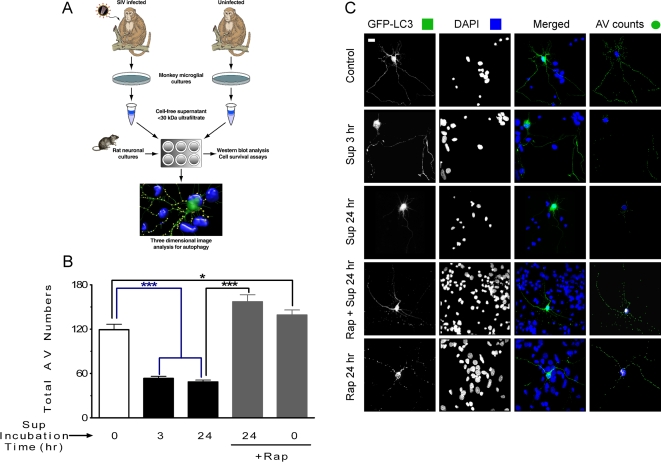

In vitro analysis of the impact of SIV-infected microglia supernatant on autophagy in primary neurons.(A) Model of experimental design, as detailed in the Materials and Methods. (B) Total AV counting results show that a significant drop in the number of AV occurs in neurons exposed to SIV-infected microglia supernatant for 3 or 24 hr. Total number of AV are significantly increased after the pretreatment with rapamycin followed by SIV-infected microglia supernatant (Sup) exposure for 24 hr. *** P<0.001, * P<0.05 for n = 6 experiments. All values are mean±SEM. AV counting using 3D model reconstruction for neurons exposed to different treatments. (C) Flattened images of multi-stack confocal optical slices of neurons transfected with GFP-LC3 (green) to label AV, and DAPI (blue) to label the nucleus. The five panels display a typical sample image of a neuron under control conditions as well as 3 hr and 24 hr exposure to SIV-infected microglia supernatant or pretreated with rapamycin prior the exposure to SIV-infected microglia supernatant. The right hand panels show a snap shot of a 3D outline of the neuron with AV marked as green spheres. Scale bar, 20 µm.